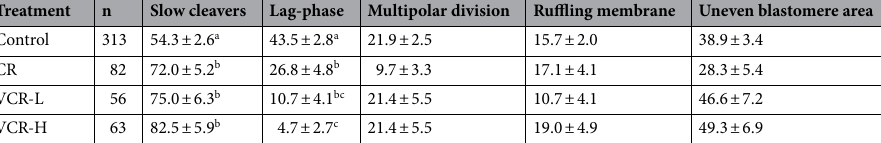
Table 6. Proportion of morphokinetic events around cleavage or first division. Percentage of zygotes that display abnormal events around the first division. Slow cleavers are considered zygotes that cleave after 32 h and 22 min. Uneven blastomere are indicates a difference between blastomere areas of more than 23.4%. Different superscripts per column (a, b, and c) represent statistical differences ( p < 0.05). Results are expressed as least square means ± standard errors. Control: fresh cumulus enclosed oocytes. Corona radiata (CR): fresh oocytes partially denuded to leave only the corona radiata. VCR-H: CR oocytes vitrified with a protocol using high concentrations of cryoprotectants (15%) in equilibration solution; VCR-L : CR oocytes vitrified with a protocol using a low cryoprotectant concentration (3%) in equilibration